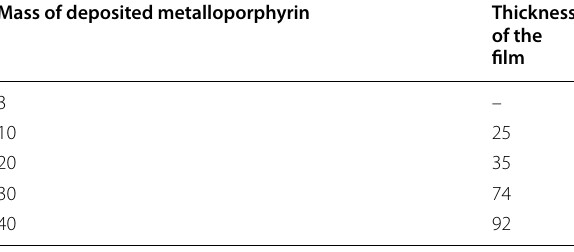
Table 1 The thickness of the metalloporphyrin thin film according to the mass of the deposited metalloporphyrin Mass of deposited metalloporphyrin